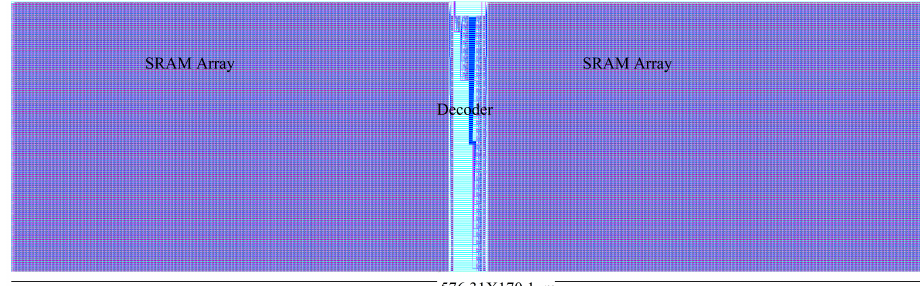
Figure 18. Layout of the proposed 512 byte SRAM bank: it has a decoder, SRAM array, sense amplifiers, multiplexers, and read and write